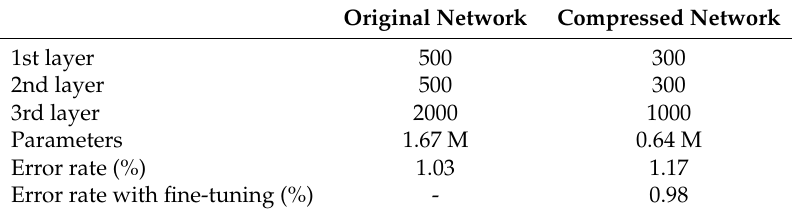
Table 1. The result of the original and compressed DBN on the MNIST dataset.